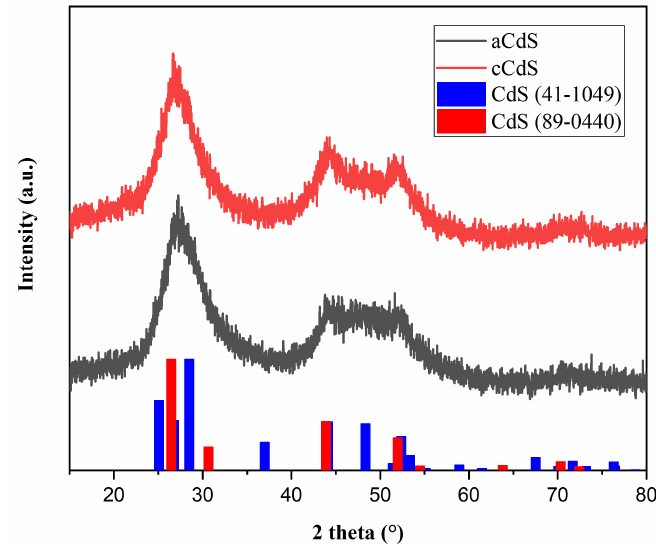
Figure 1. XRD patterns of mechanochemically synthesized aCdS and cCdS samples.